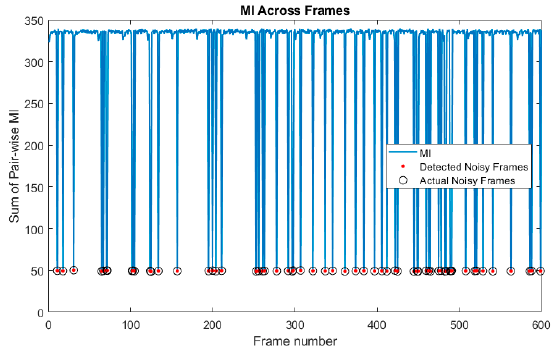
Figure 14. Sum of normalized mutual information calculated between all the frames and one another. This information is used to detect the presence of corrupted frames so they can be removed.